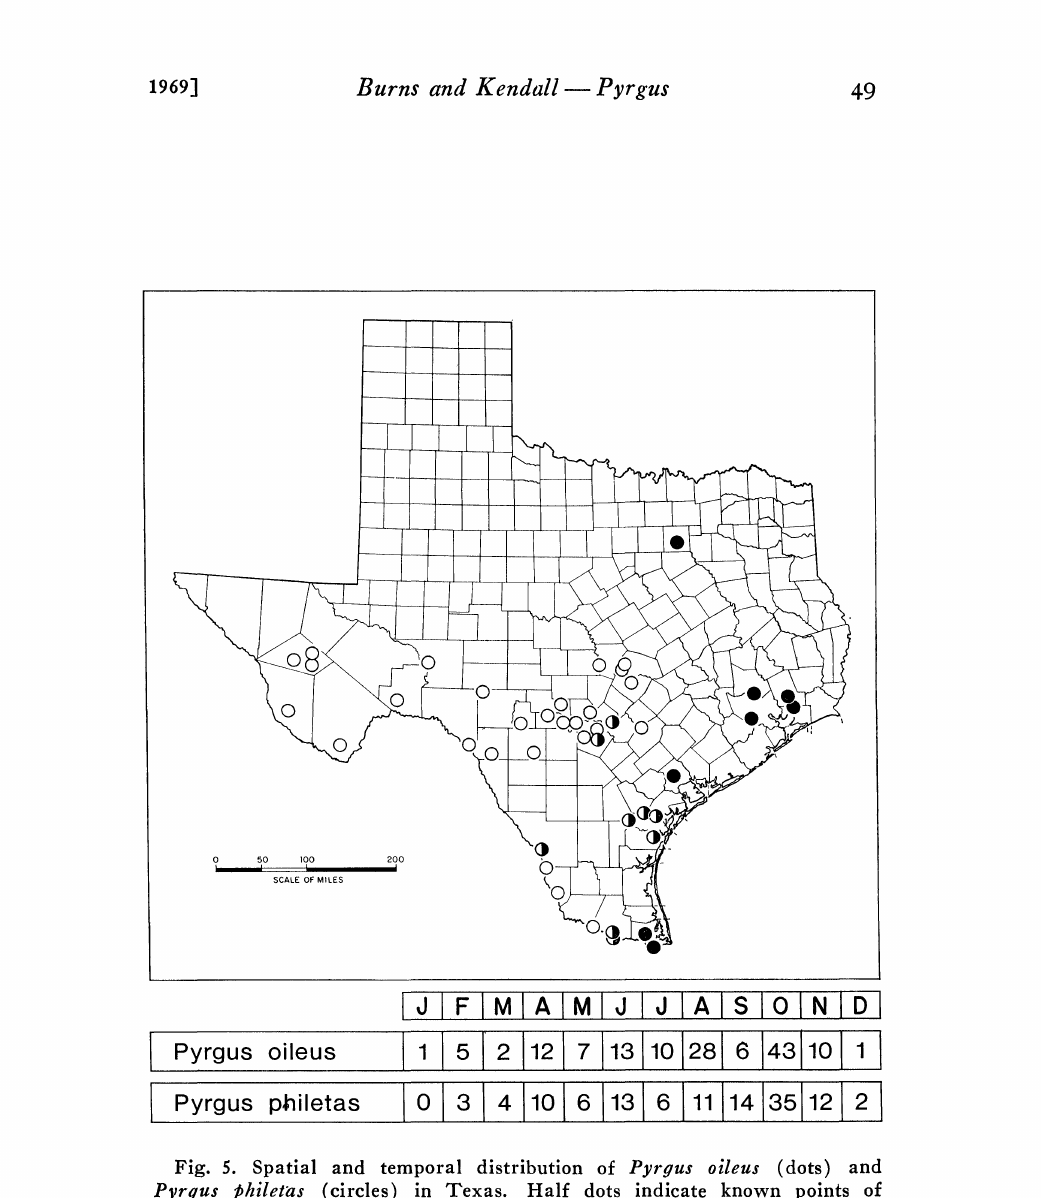
Fig. 5. Spatial and temporal distribution of PyrtTus oileus (dots) and Pyrgus khilet’as (circles) in Texas. Half dots indicate known points of sympatry. The more interior and northern records of P. oileus probably represent transient populations (see text). Temporal distribution is crudely expressed in a month by month tally of all dated specimens